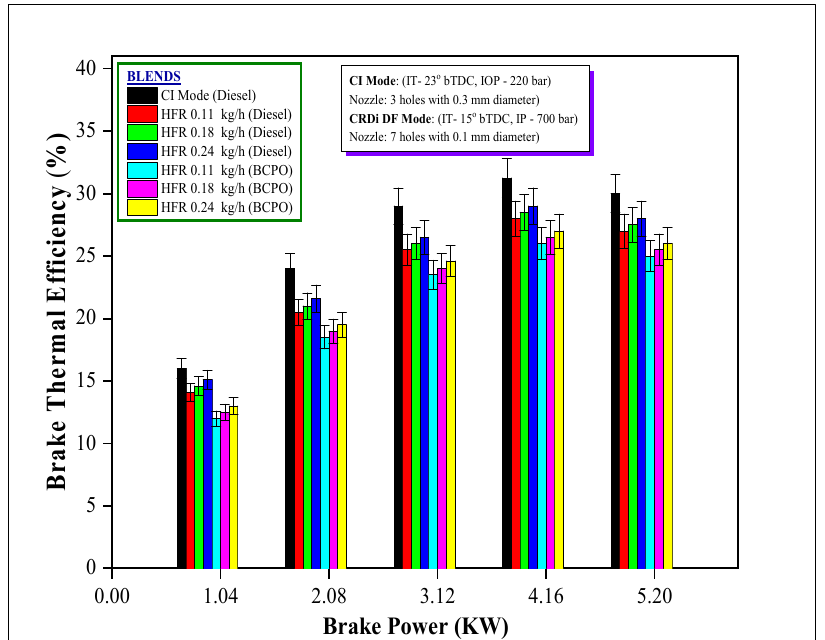
Figure 5. HFR and BP influence on CRDi engine BTE.